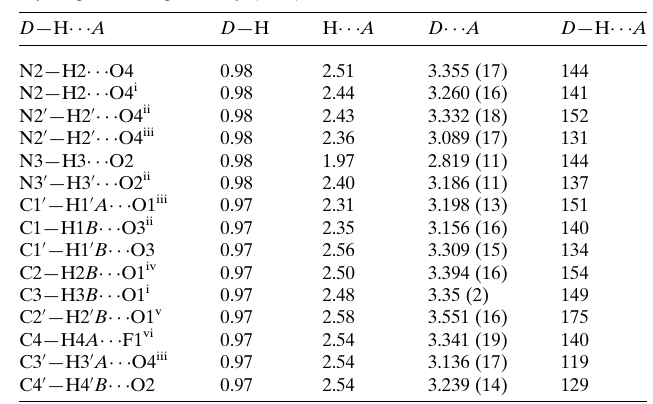
Table 2 Hydrogen-bond geometry (A˚ , (cid:2)